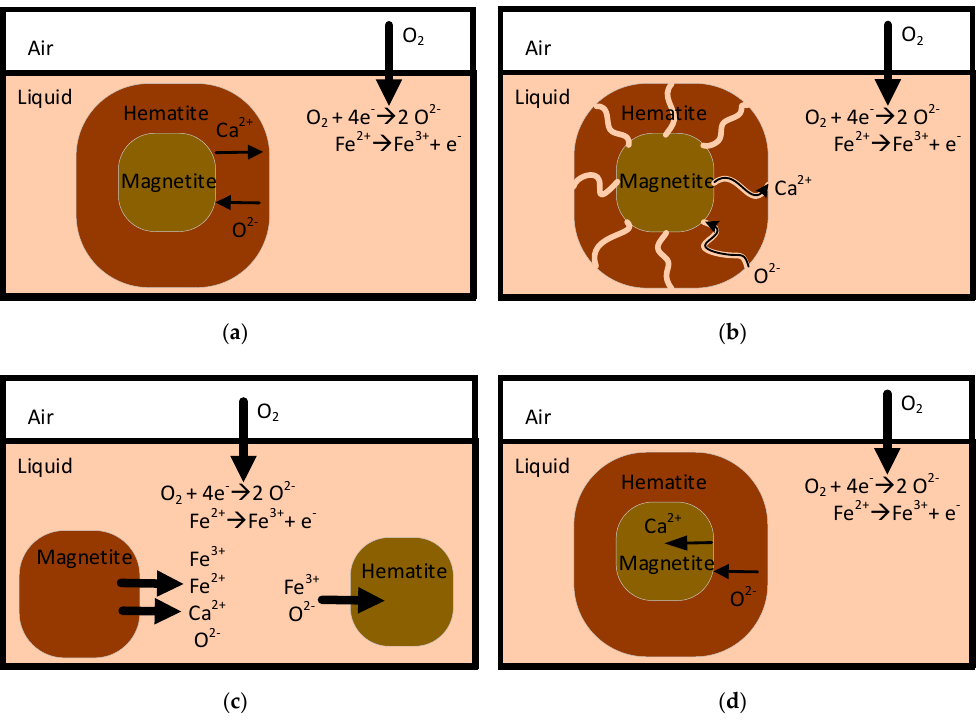
Figure 24. Schematic of liquid-facilitated magnetite oxidation ( a ) dense hematite on magnetite with calcium rejection into the melt, ( b ) porous hematite on magnetite, ( c ) isolated hematite and magnetite and ( d ) dense hematite on magnetite with calcium rejection into the magnetite.